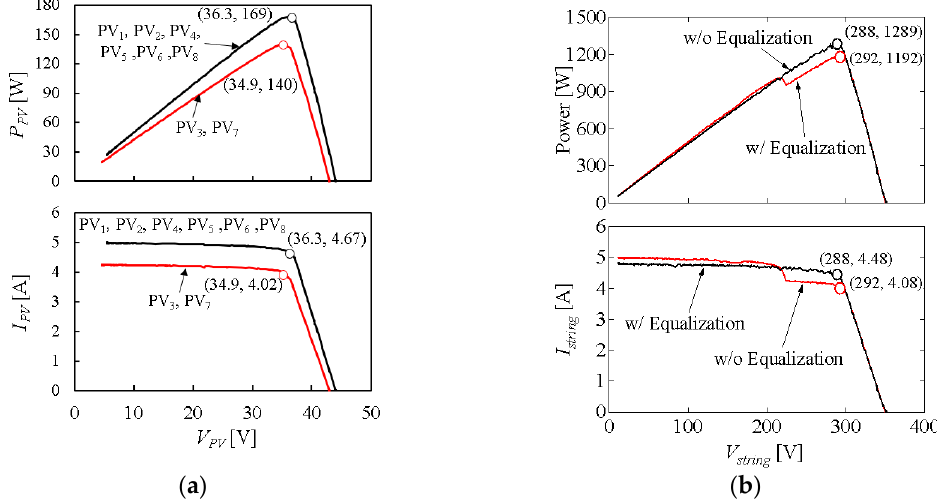
Figure 19. Experimental results of extended DPP converter. ( a ) Individual panel characteristics used for experiment; ( b ) Measured string characteristics with/without proposed DPP converter.